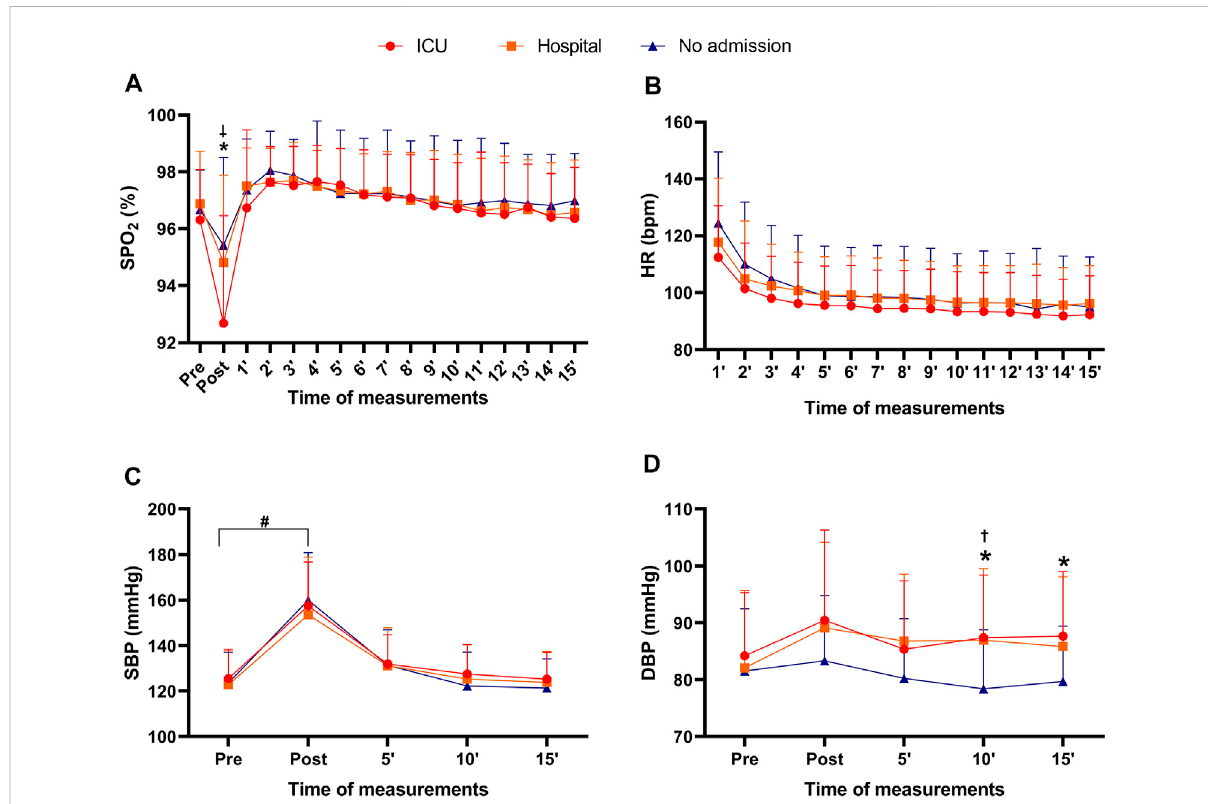
FIGURE 3 Peripheraloxygensaturation,heartrate,systolicanddiastolicbloodpressurebefore,during,andafterBrucetestingatdifferenttimesinCOVID- 19 survivors in the ICU, hospitalized, and non-hospitalized groups. Note: data are presented as the mean and (±) standard deviation; Panel (A) = peripheral oxygensaturationbeforetheBrucetest,subsequentlyafter,andfor15 minafterthetest;Panel (B) =heartrateattheendoftheBrucetest and for 15 min after the test; Panel (C) = pre-test systolic blood pressure, subsequently after the test, 5 min after the test, 10 min after the test and 15 min after the test; Panel (D) = pre-test diastolic blood pressure, subsequently after the test, 5 min after the test, 10 min after the test and 15 min after the test; %SPO 2 = peripheral oxygen saturation; HR = heart rate; SBP = systolic blood pressure; DBP = diastolic blood pressure; * = signi fi cant difference between non-hospitalized and ICU; † = signi fi cant difference between the non-hospitalized and hospitalized; ‡ = signi fi cant differencebetweenICUandhospitalized;#=signi fi cantdifferencebetweenpreandposttimesforthethreeexperimentalgroups.Two-wayANOVA with Bonferroni post hoc test. Level of signi fi cance established = p <